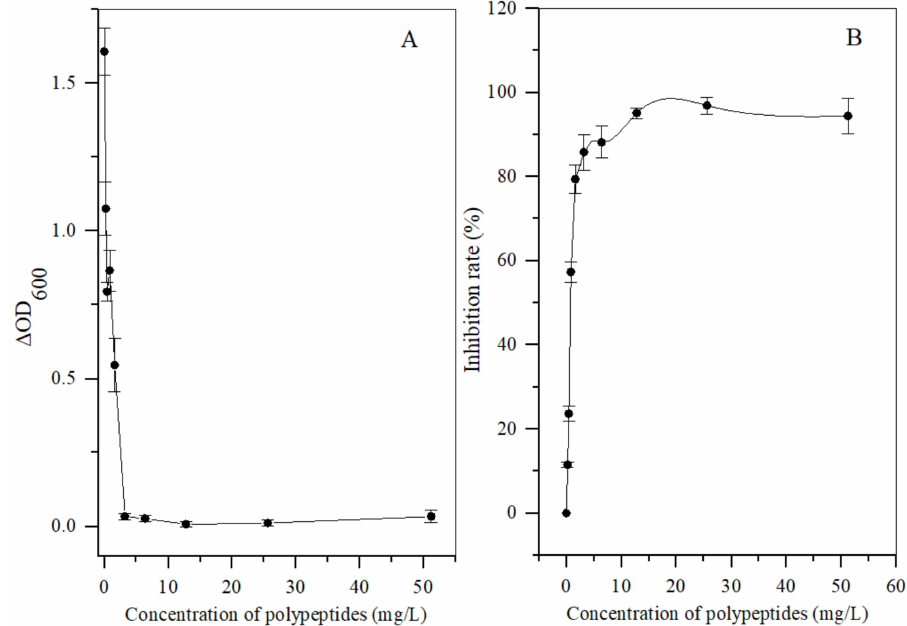
Figure 3. Antifungal activity in vitro of polypeptides with a molecular weight from 3 kDa to 5 kDa produced by B. brevis DTM05 on A. carbonarius H9. ( A ) effects of the polypeptides with different concentrations on the spore growth of A. carbonarius H9; ( B ) effects of the polypeptides with different concentrations on the spore survival rate of A. carbonarius H9).